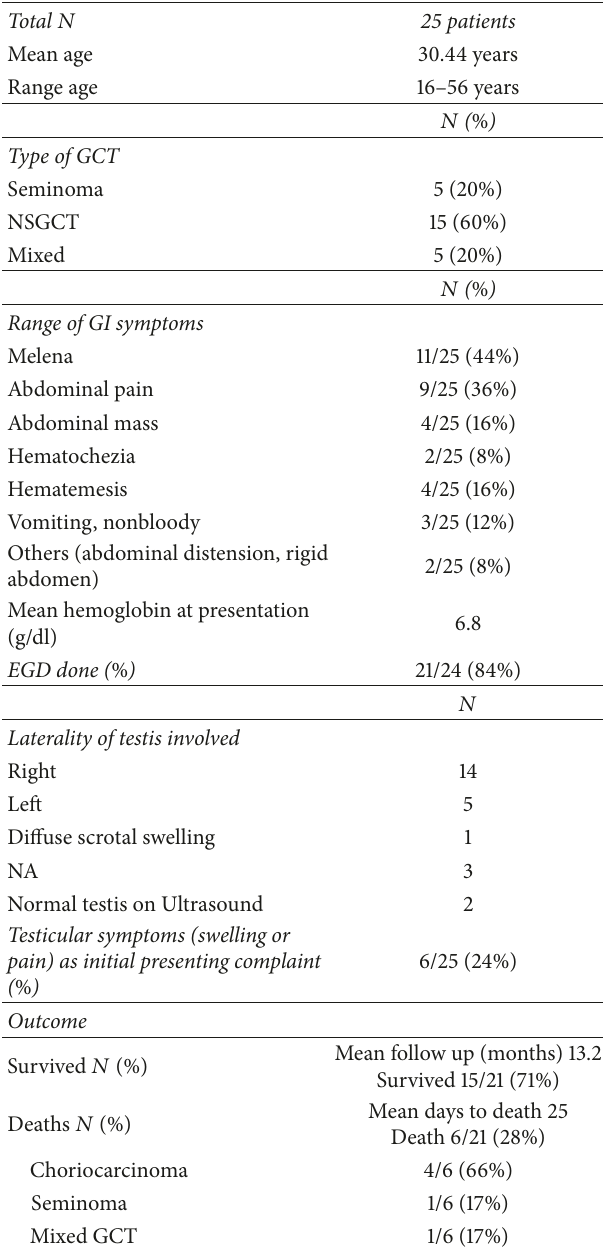
Table 1: Summary table showing studies reporting gastrointestinal involvement of testicular germ cell